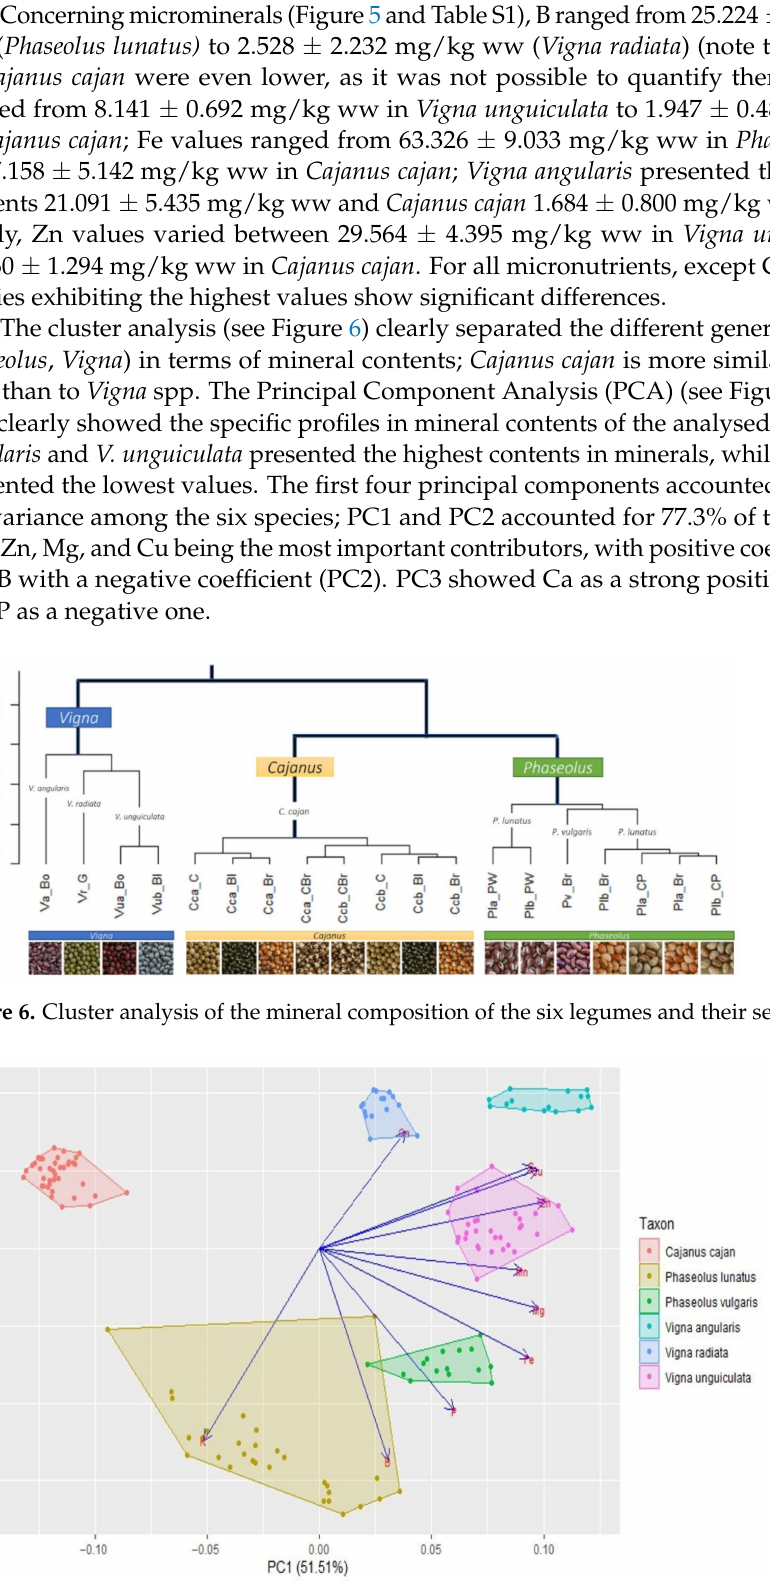
Figure 7. Principal components analysis based on the mineral content of Cajanus cajan , Phaseolus lunatus , P. vulgaris , Vigna angularis , V. radiata , and V. unguiculata (seed colour types pooled together for each species). The length of the arrows represents the differences in the variance explained in relation to the other